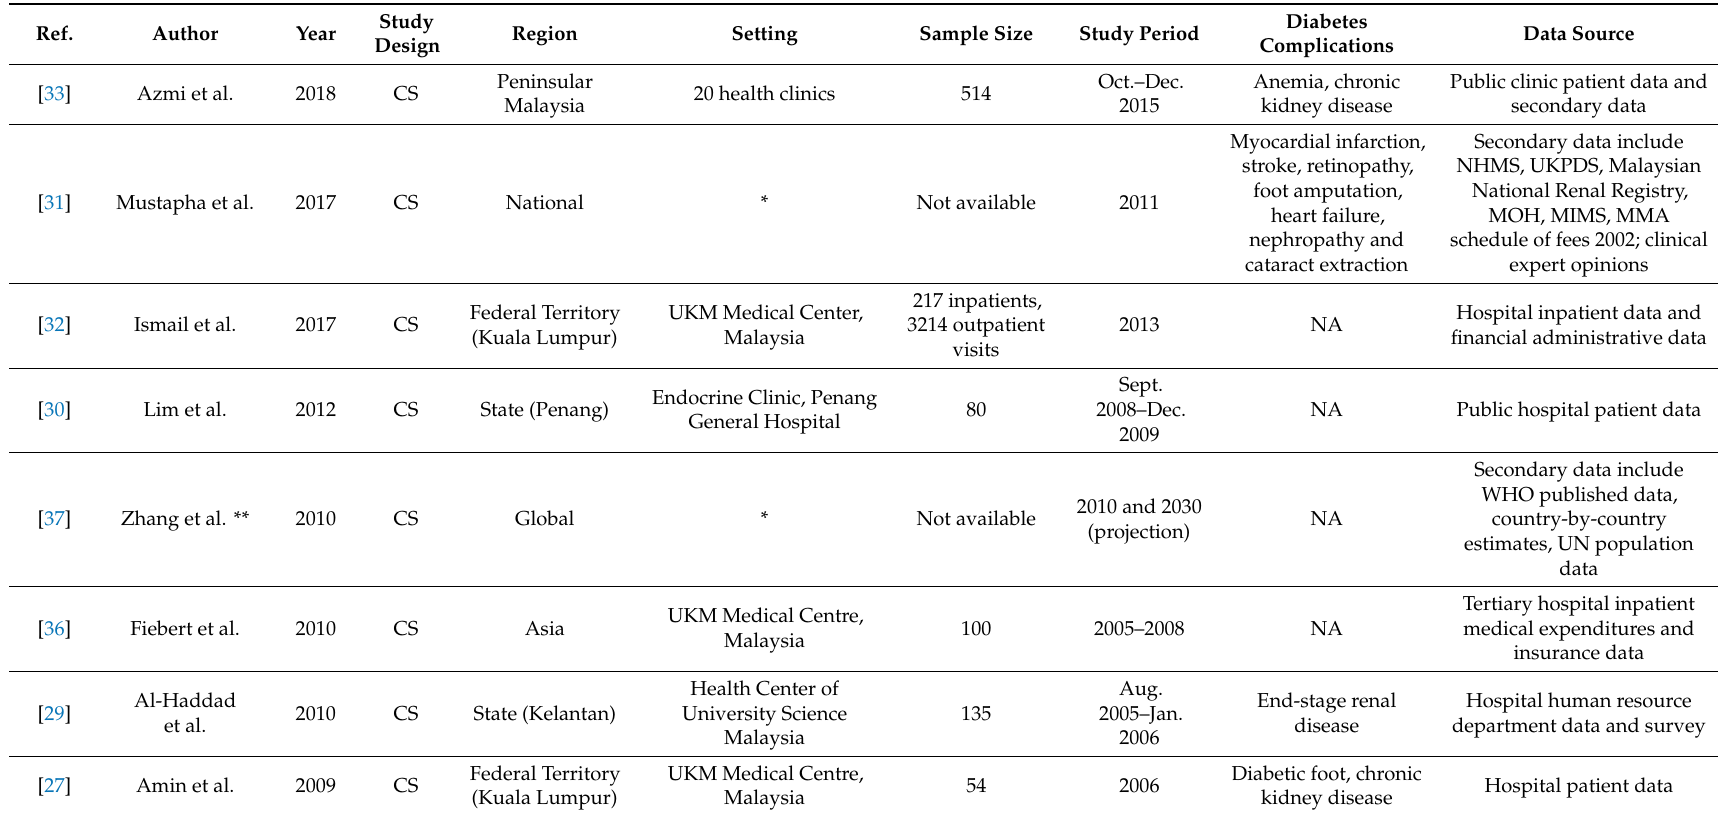
Table 2. General characteristics of the studies included in the